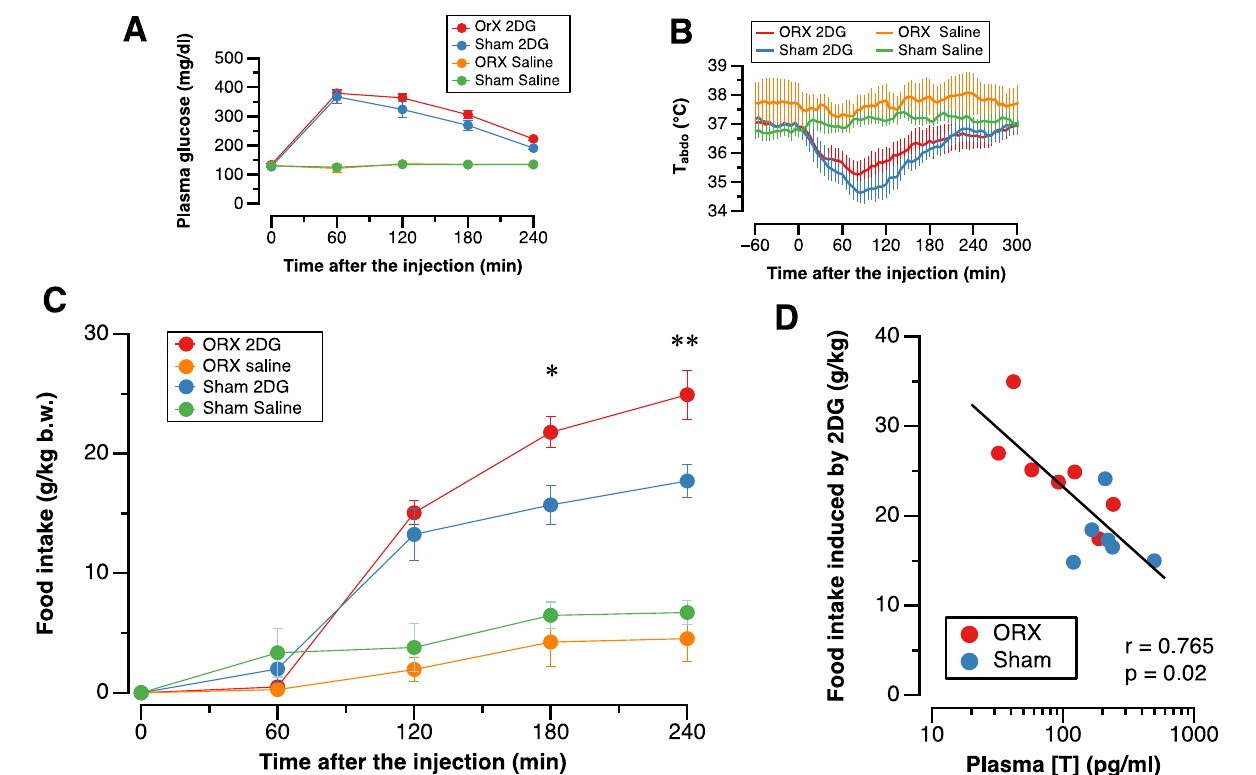
Figure 2. Effect of orchiectomy on responses to inatravenous 2-deoxy-D-glucose administration. ( A ): Plasma glucose concentration, ( B ): Intra-abdominal temperature (T abdo ). ( C ): Cumulative food intake ( C ) after 2-deoxy-D-glucose (2DG; 400 mg/kg body weight, i.v.) or physiological saline (Sal) administration in the orchiectomized (ORX) and the sham-operated (Sham) groups. Data are shown as mean and SE ( n = 7 in the ORX_2DG group; n = 6 in the Sham_2DG; n = 4 in the ORX_Sal; and n = 4 in the Sham_Sal group). * and **: significant difference between the ORX_2DG group and the Sham_2DG group at p < 0.05 and p < 0.01, respectively. ( D ): Relationship between 2-deoxy-D-glucose (2DG)-induced food intake and plasma testosterone concentration ([T]) in the orchiectomized (ORX) group and in the sham-operated (Sham) group. 2DG-induced food intake was significantly inversely correlated with plasma [T] (r = 0.77; p = 0.02).